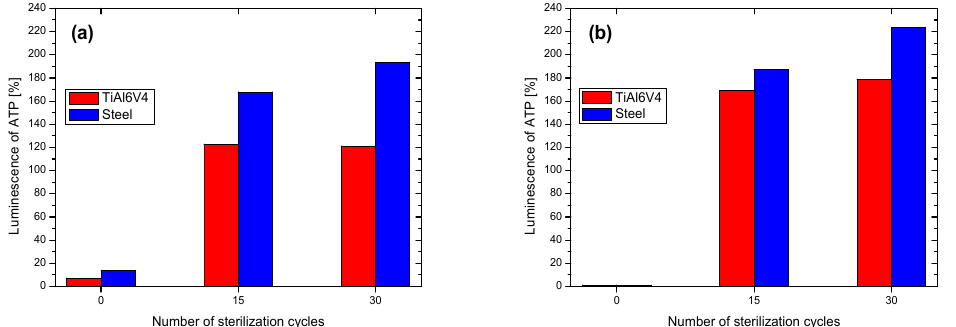
Figure 11. Luminescence of ATP of ( a ) Zn-SiO x (Zn(NO 3 ) 2 flow rate of 100 µ L/min) and ( b ) Cu-SiO x films (Cu(NO 3 ) 2 flow rate of 50 µ L/min) after 0, 15, and 30 sterilization cycles.